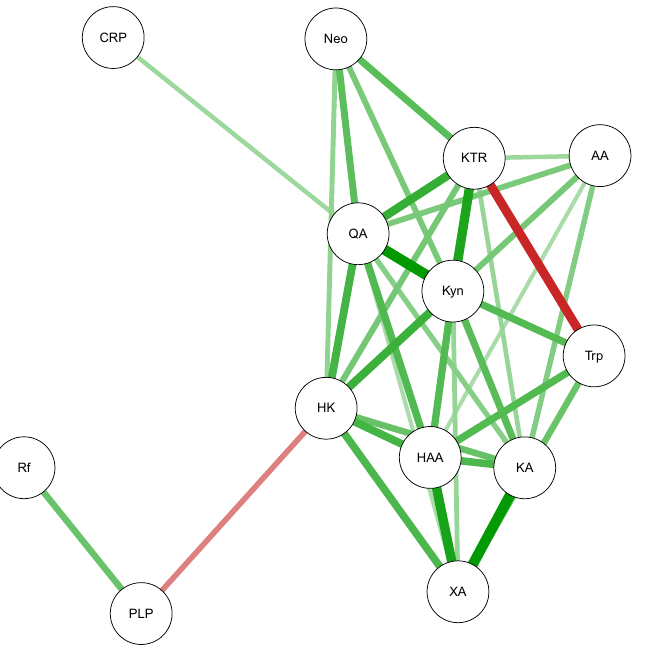
Figure 2. Qgraph plot of spearman correlations (including only absolute values > 0.2 to avoid a crowded figure) adjusted for cohort, sex, age, BMI, creatinine, cotinine and sample storage time. Green lines show positive correlations, red lines show inverse correlations. The color saturation and thickness of lines are proportional to the strength of the correlations. The figure illustrates the data given in Supplementary Table S2. AA: anthranilic acid; CRP: C-reactive protein; HAA: 3-hydroxyanthranilic acid; HK: 3-hydroxykynurenine; KA: kynurenic acid; KTR: kynurenine/tryptophan ratio; Kyn: kynurenine; Neo: neopterin; PLP: pyridoxal 5 ′ -phosphate; Rf: riboflavin; Trp: tryptophan; QA: quinolinic acid; XA: xanthurenic acid.